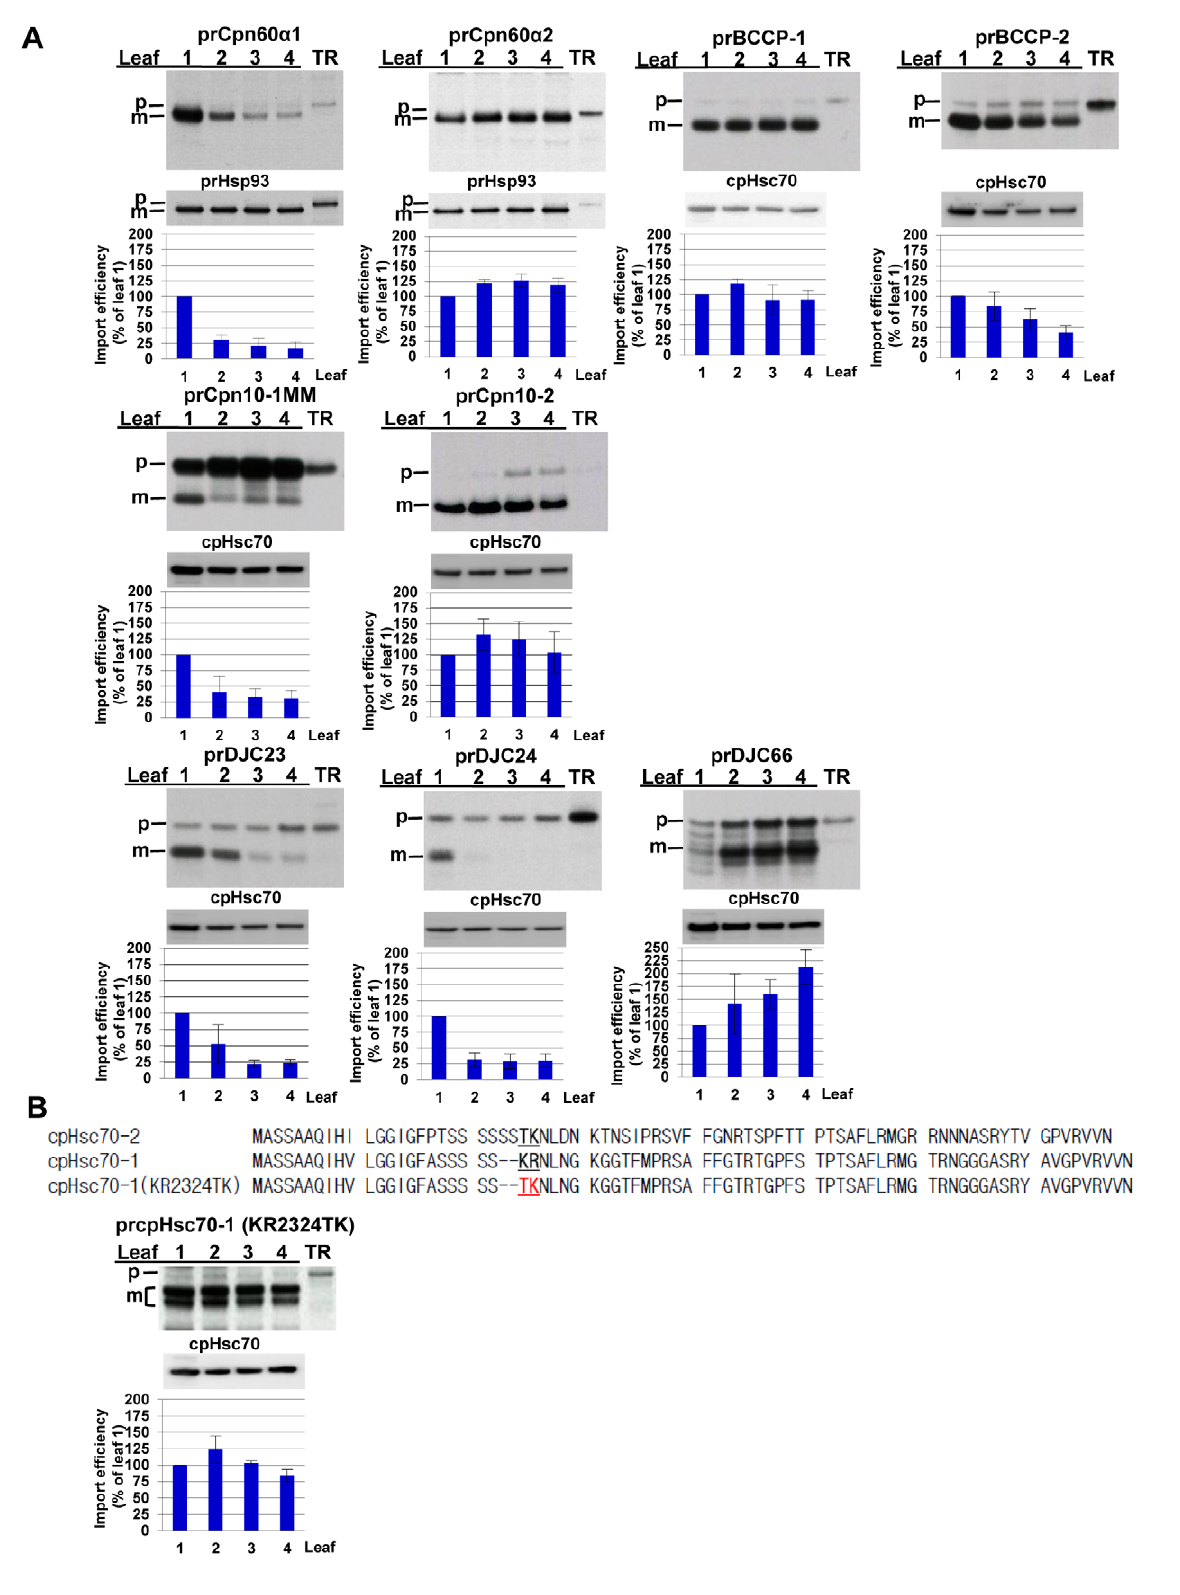
Figure 7. Different isoforms are preferentially imported into chloroplasts of different ages because of sequence differences in transit peptides. (A) Import of different isoforms of gene families. (B) Transit peptide sequences of prcpHsc70-2, prcpHsc70-1, and prcpHsc70- 1(KR2324TK), and import of prcpHsc70-1(KR2324TK). Various precursor proteins were imported into chloroplasts isolated from pea leaves of different ages. Intact chloroplasts were re-isolated after the import reaction and analyzed by SDS-PAGE and autoradiography. The amount of endogenous